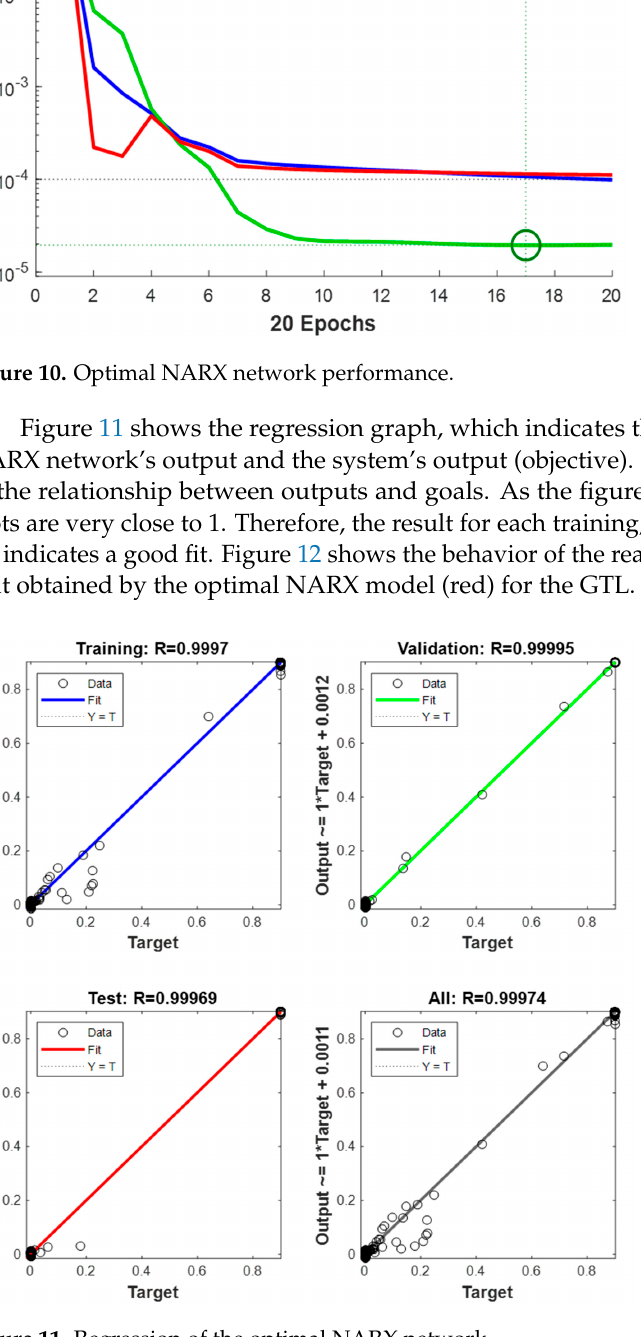
Figure 12. Behavior of the real angular velocity and the optimal NARX model for the GTL.